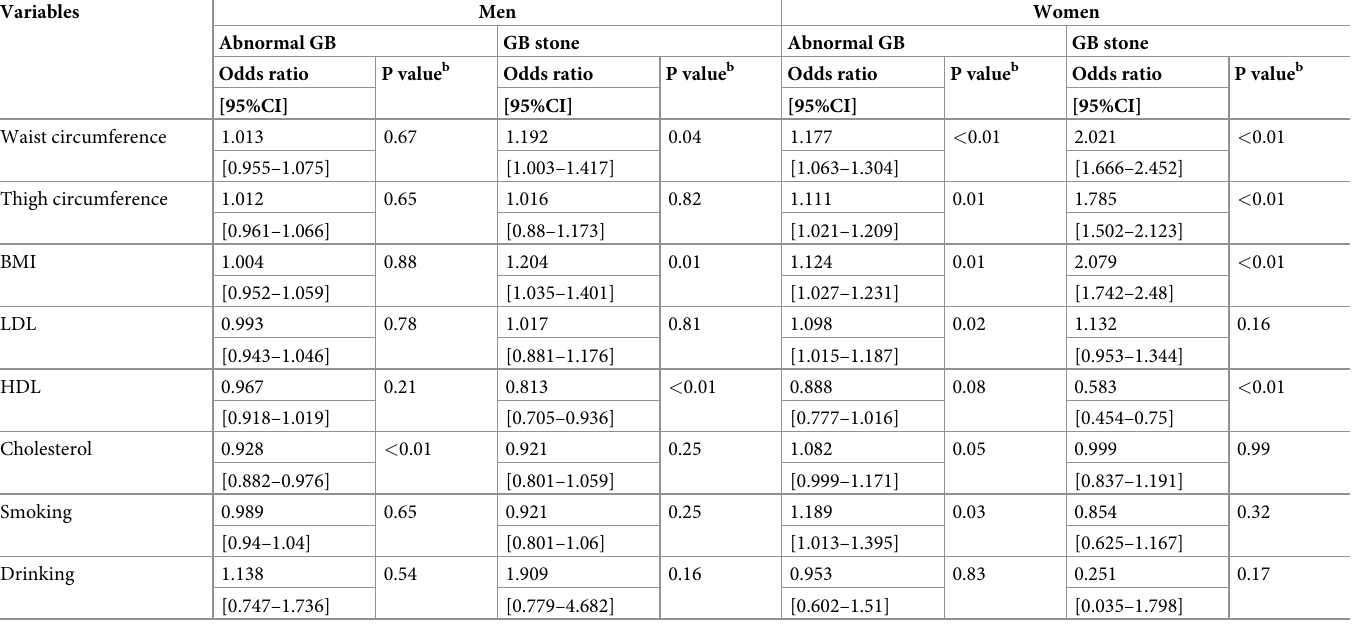
Table 4. Univariate analysis of risk factors for abnormal GB finding and GB stones.